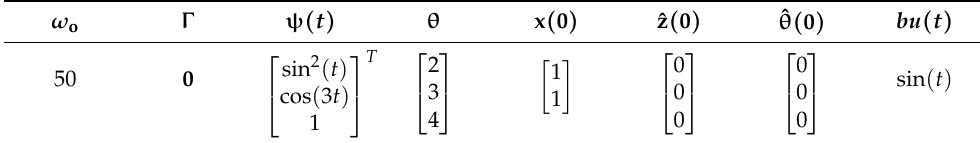
Table 1. Parameters of the simulation of ESO without